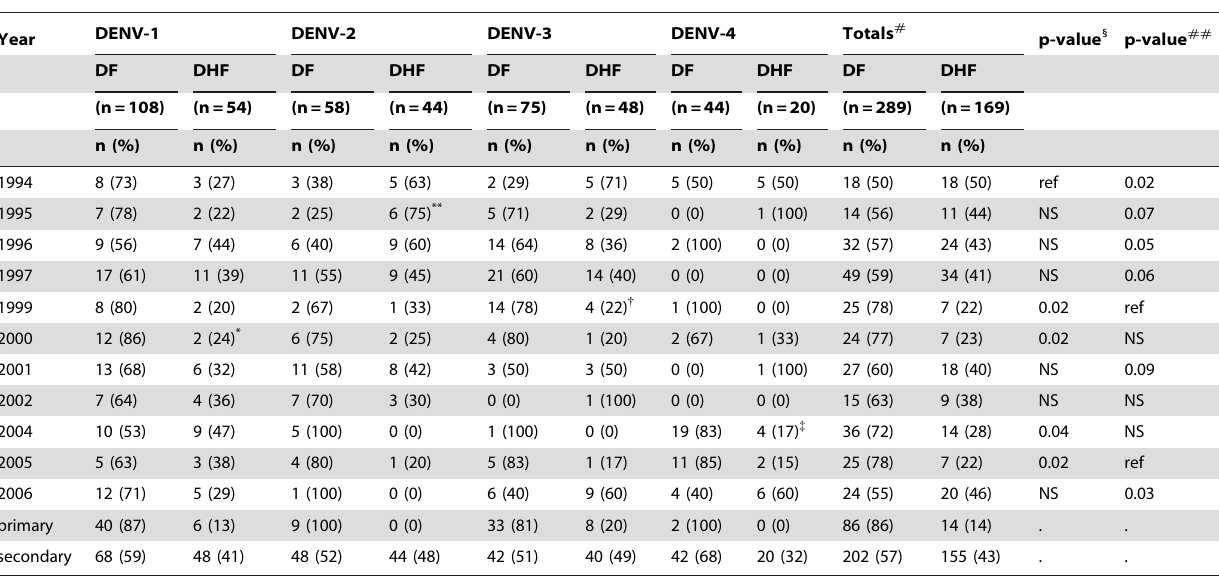
Table 2. Serotype-specific data.